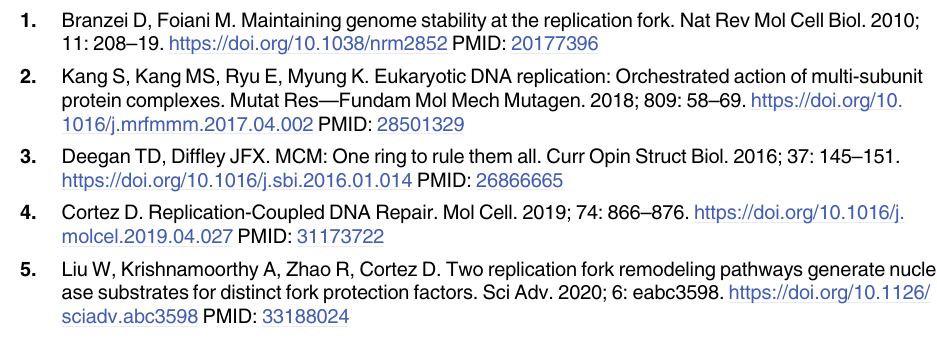
anti-BrdU antibody under denaturing conditions. DNA content (PI) of BrdU positive cells is shown. ( D ) as in (C) but with DLD-1 cells. See data used for quantification in S1 File. (PDF) S7 Fig. Effect of B02 on γ H2AX and 53BP1 foci in S phase HCT116 cells. ( A ) Representative images of γ H2AX, CldU and EdU immunofluorescence used for the quantification in Fig 6C are shown. ( B ) Cells were treated as in Fig 6, but 53BP1 instead of γ H2AX was analyzed by immunofluorescence. Related to Fig 6. See data used for quantification in S1 File. S1 Raw images. Original uncropped and unadjusted